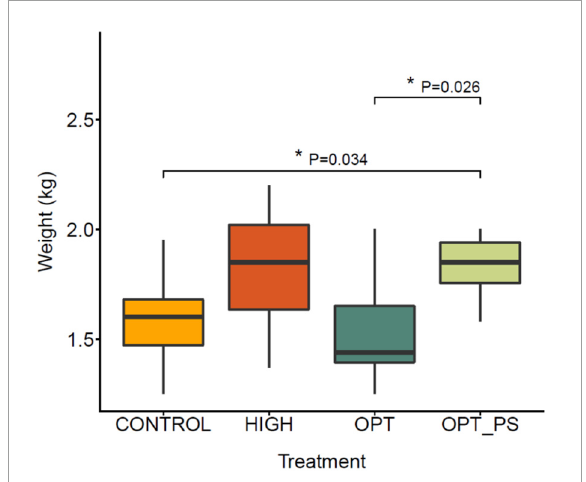
FIGURE1 Box plot of the final body weight distribution of broiler chickens in different groups at 37 days of age. Control group (CONTROL); higher dose (HIGH): 50 mg/kg bw/day enrofloxacin; optimized dosing (OPT): 12.5 mg/kg bw/day enrofloxacin; optimized dosing with synbiotic supplementation (OPT_PS): 12.5 mg/kg bw/day enrofloxacin administration with synbiotic supplementation). FDR-corrected p -value from the Mann–Whitney statistical analysis is shown (* P <